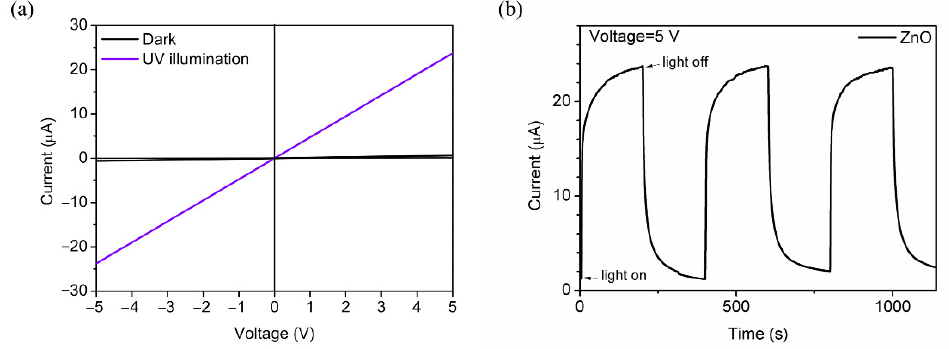
Figure 5. ( a ) I–V characteristics of ZnO photodetector under dark and 365 nm UV illumination. ( b ) I-t characteristics of ZnO photodetector at 5 V bias with 365 nm UV illumination switching on and off.